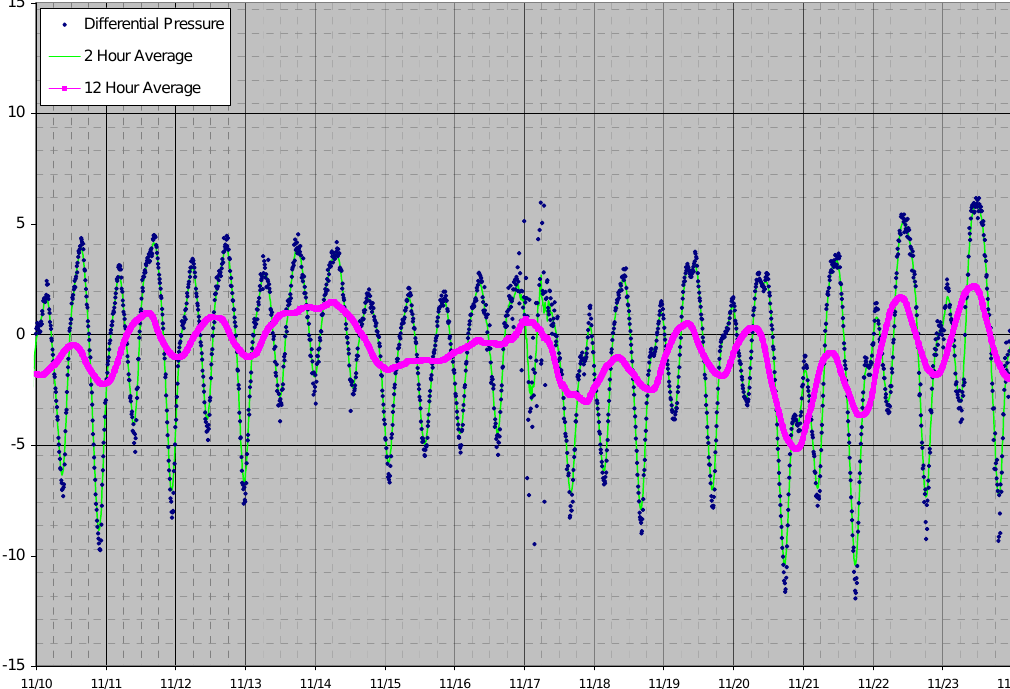
Figure 11. Differential pressure data, with 2 and 12 hour averages, from one of the DP loggers deployed in Waquoit Bay, MA, in November